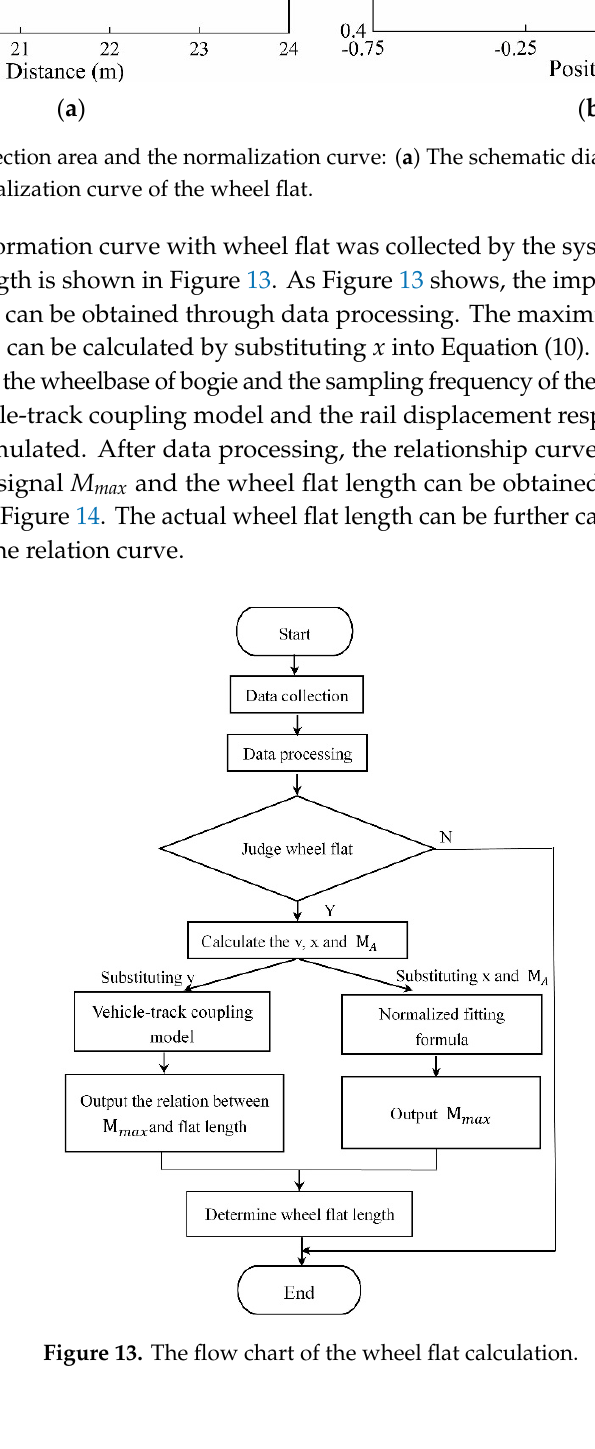
Figure 14. The relation curves between the maximum amplitude of the wheel flat and the flat length. 5. Results and Discussion In the above sections, the measurement principle of the system was introduced, and the influencing factors of flats detection were analyzed by establishing the simulation model. The simulation results were normalized to realize quantitative measurement. In order to verify the effectiveness of the system, the laser collimation method-based wheel flat detection system was mounted in laboratories and railway sites, respectively, and experiments in the laboratory and on- site were conducted.